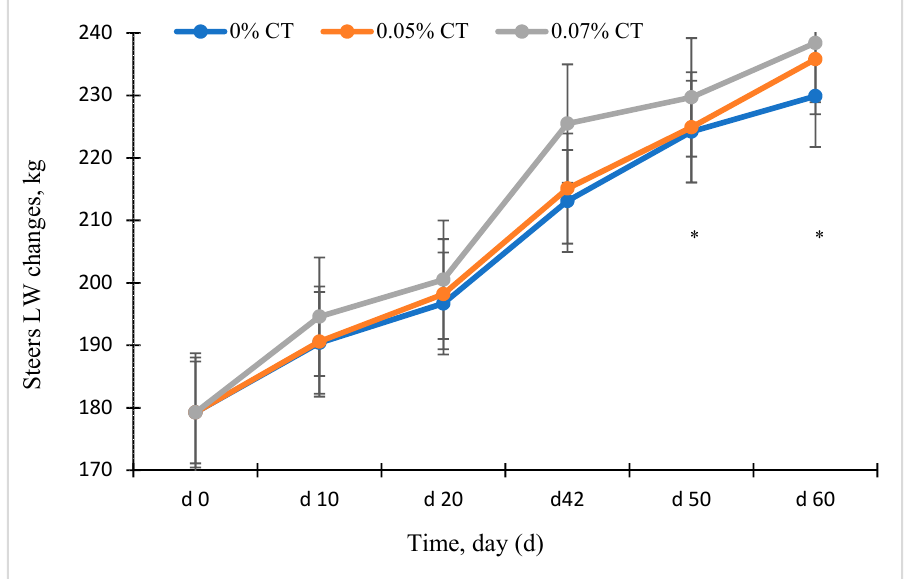
Figure 1. Effects of condensed tannins (CT) on the animal live weight (LW) changes in rumen-cannulated steers grazing winter wheat forage. Animal LW was measured on day (D) 0, 10, 20, 42, 50, and 60. Results are mean values ± SEM ( n = 6). Initial body weight from d 0 was used as a covariate. Statistical significance: * p < 0.05. Values without asterisks are not significantly different ( p < 0.05).